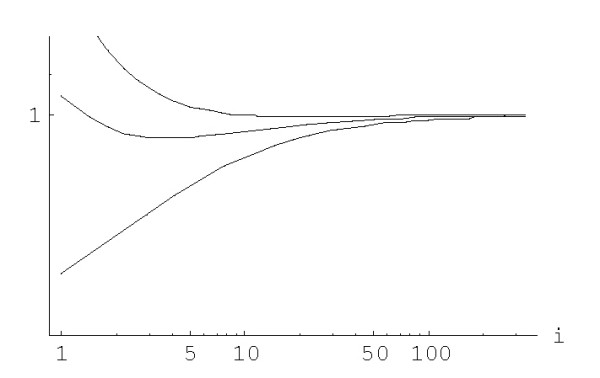
The ratio β i/μ i against family size i for the rational BDIM depending on the model degree d:d = 1, d = 1.6, d = 2 (from bottom to top), in double logarithmic scale. The model parameters are for Drosophila melanogaster.